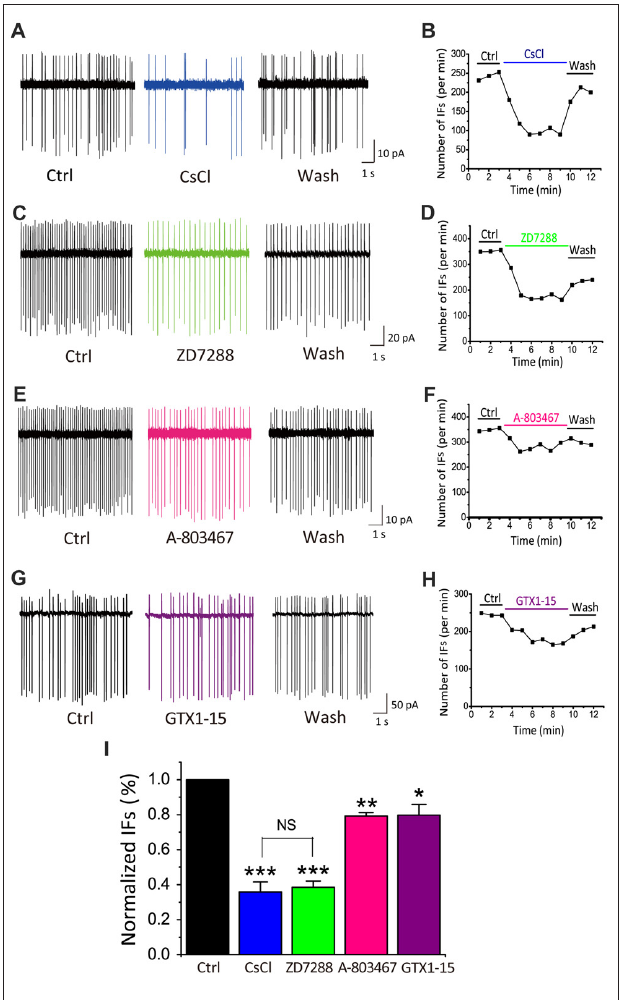
FIGURE 3 | HCN channels play a dominant role in generating IFs over TTX-resistant sodium channels and T-type calcium channels in P5–10 CN neurons. (A–H) Example traces and time course are shown for control (in the presence of synaptic blockers), subsequent application and washout of HCN blockers CsCl (2 mM), ZD7288 (40 µ M), or TTX-resistant sodium channel blocker A-803478 (10 µ M) or T-type calcium channel blocker GTX1–15 (0.01 µ M). The control solution was applied for 3 min, followed by the bath application of different blockers for 6 min and a washout for another 3 min. Data was collected after 2 min drug application to achieve equilibrium. (I) Summary plot of the inhibition of each antagonist, showing significantly larger effects of HCN channels blockers (CsCl and ZD7288), as compared with other two pacemaker channels. Normalized data were collected by taking the average of spikes for each 1-min bin during 6 min drug